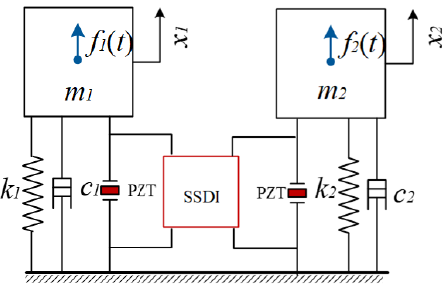
Figure 3. A 2-DOF (degree-of-freedom) mechanical system with dual-connected SSDI.